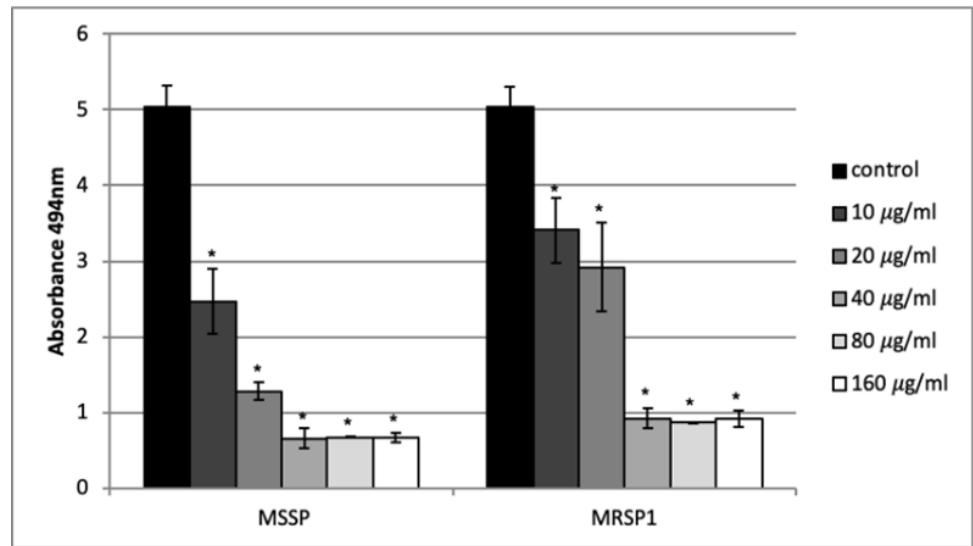
Figure 4. Effect of abietic acid on one-day-old biofilms of S. pseudintermedius . Upper panel: biofilm biomass obtained by crystal violet staining; bottom panel: biofilm vitality obtained by XTT assay. Bars represent the average values ± SD from three independent experiments. * represents p < 0.05.